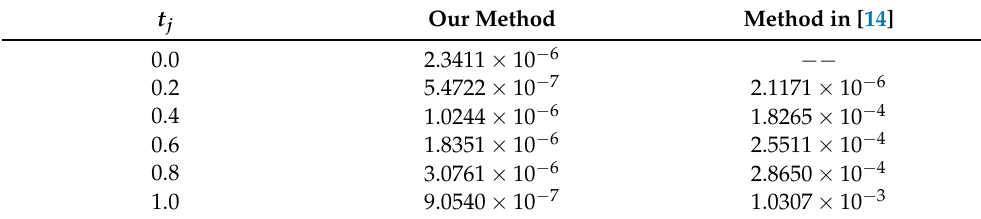
Figure 2. ( a ) Exact and approximate solutions, ( b ) absolute error function for N = 25 for Example 1. Table 1. Absolute errors at equally spaced points for N = 25 of Example